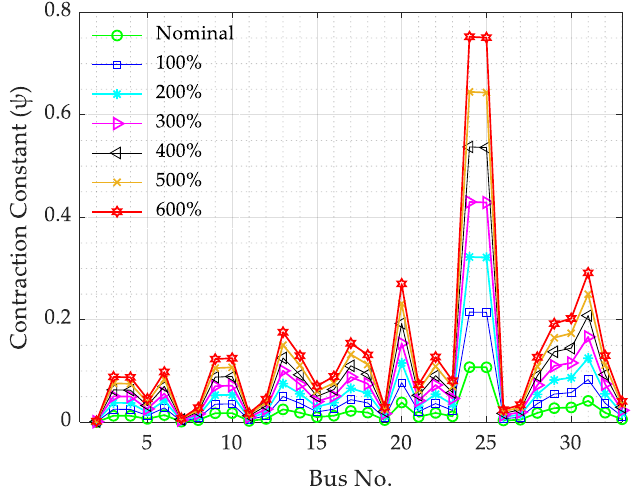
Figure 14. Value of the contraction constant for each node (33-node) for different loading conditions.